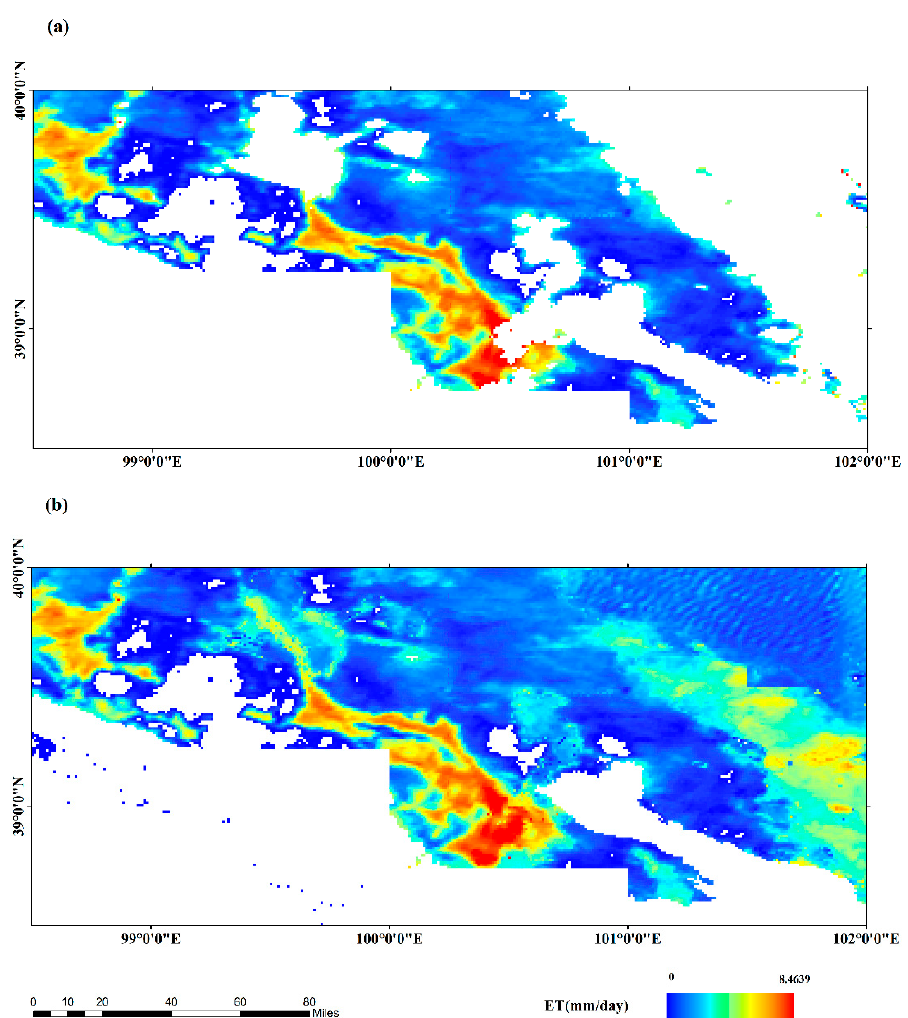
Figure 13. ET map on 209th, 2009: ( a ) before reconstruction, ( b ) after reconstruction, where ET: evapotranspiration.